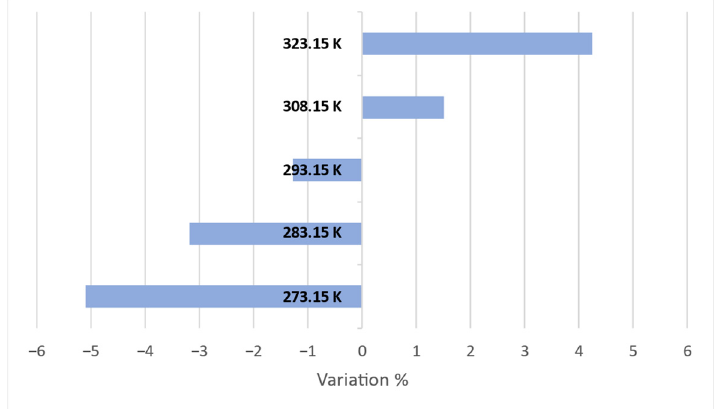
Figure 11. PCT vs. air temperature—variation (%).